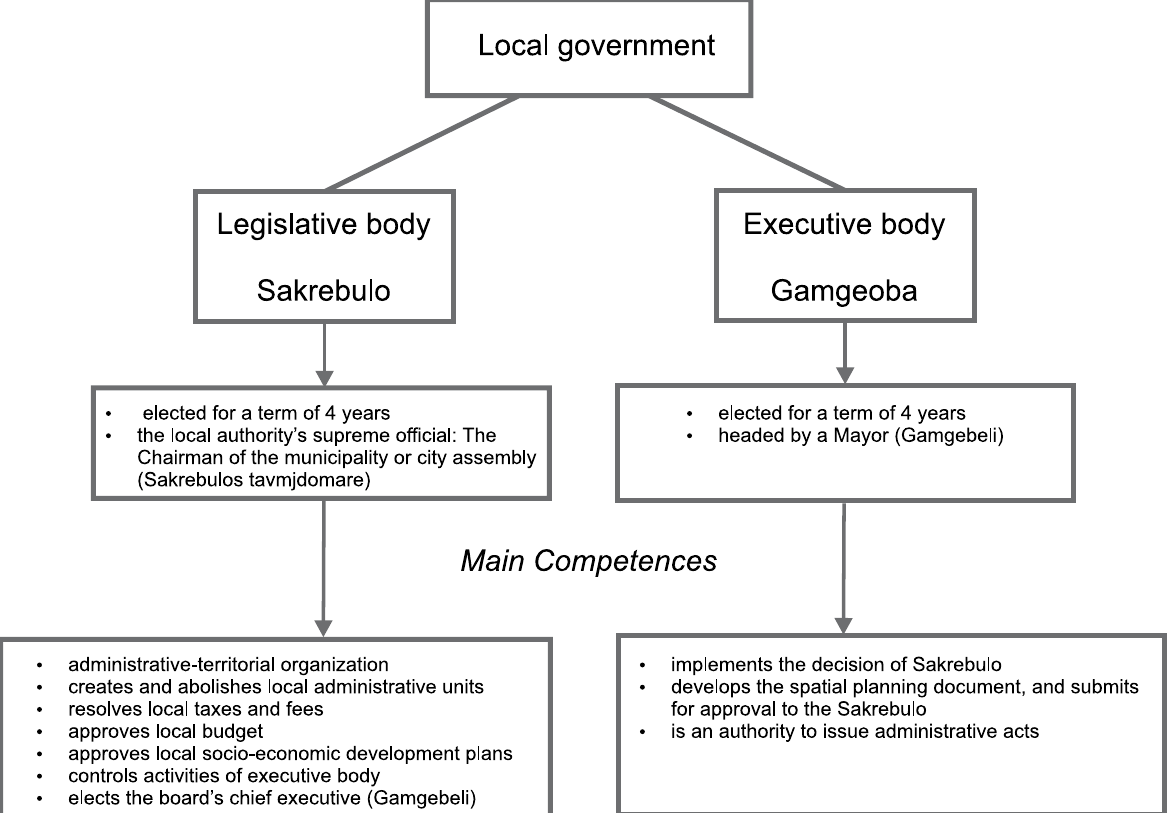
Fig. 6. Structure and competences of the local Government of